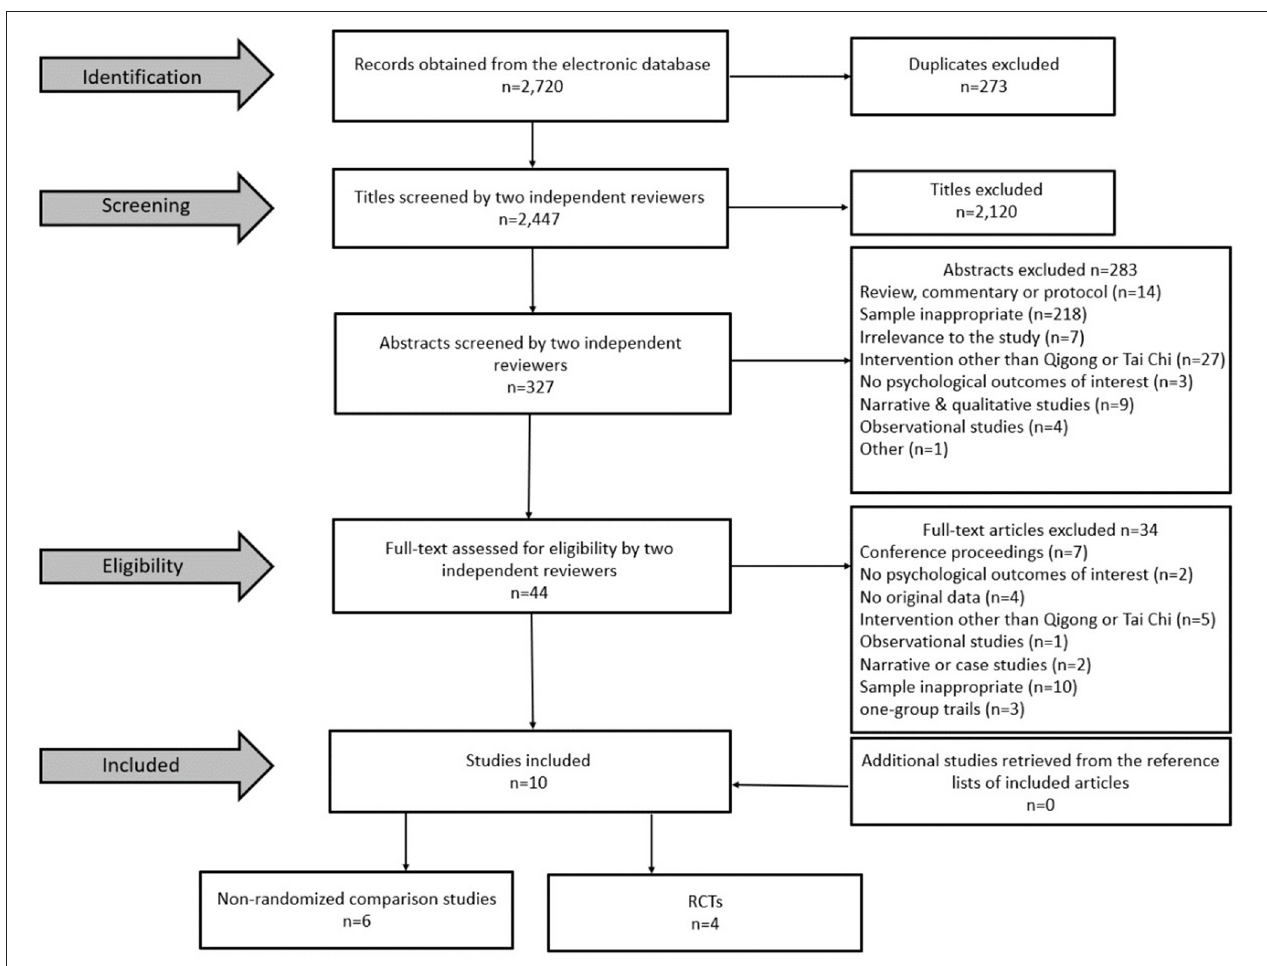
FIGURE 1 | Flowchart of research article selection (RCT, Randomized Controlled